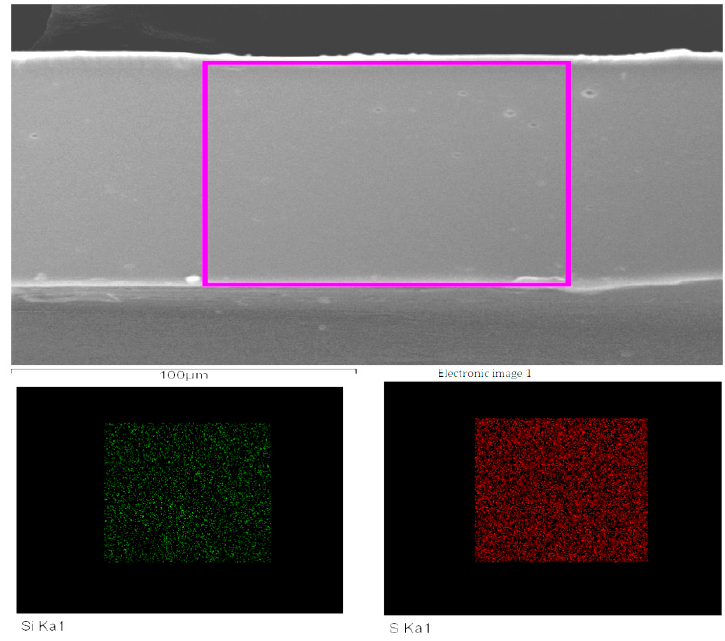
Figure 4. The scanning electron microscopy (SEM) image and EDX distribution maps of Si and S for the cross section of SPEKEBI-2.5-SiO 2 membrane.